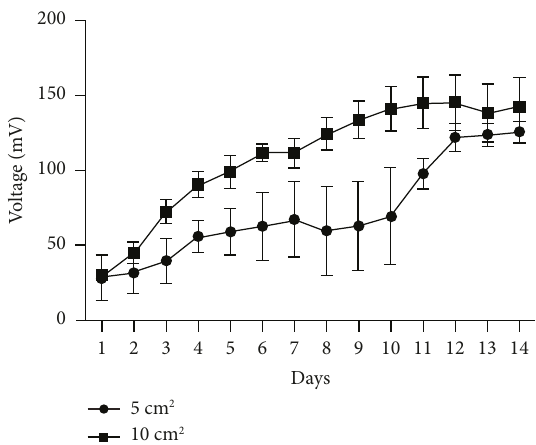
Figure 4: Comparative effect of the surface area of different size platinum carbon cloth electrodes on voltage (mV ± SD) output by H. salinarum at pH 6.4 over a period of 14 days at 37 ° C with oscillation. Each data point is the daily average voltage (mV) recorded every 30 minutes from 2–4 separate experiments. An unpaired T -test with welch correction determined doubling the electrode size has significant ( p � 0 . 01) effect on voltage under oscillating conditions.